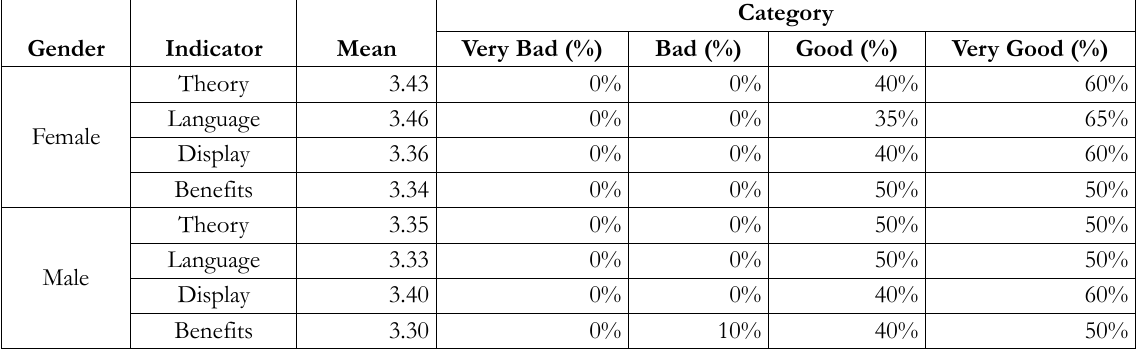
Table 6. Seventh Grade Student’s Perception of the Use of Web-based Character Assessment based on Student Perception Indicators